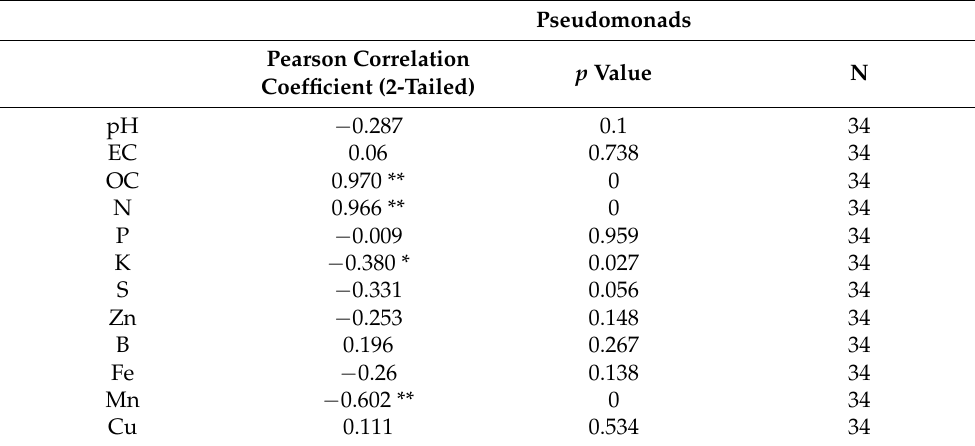
Table 2. Correlation between the population of Pseudomonads and related genera in soil with lateritic soil chemical properties (using t